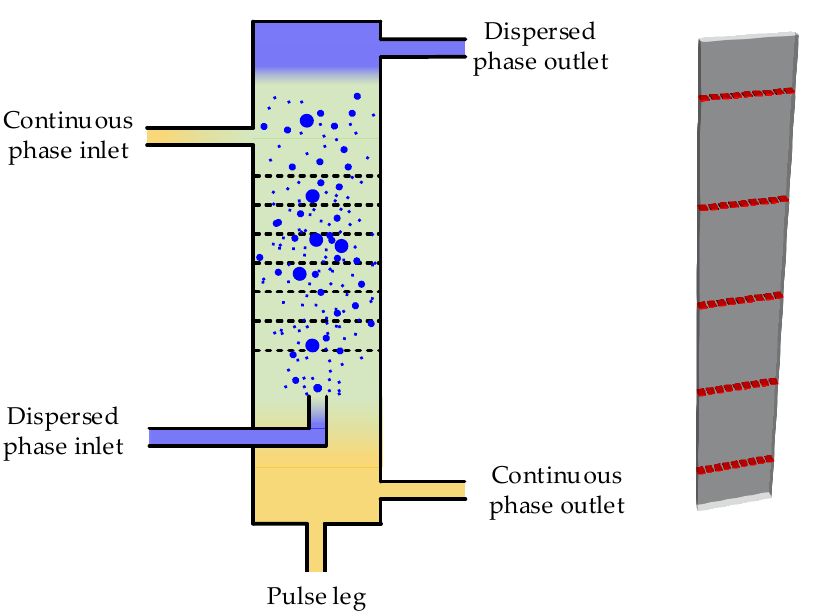
Figure 6. Schematic representation and a subsection of the axisymmetric computational domain used for the PSEC simulation.